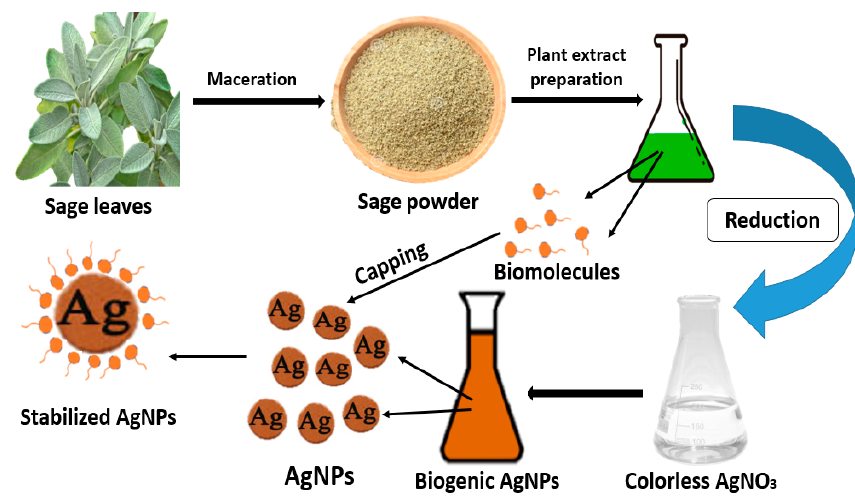
Figure 2. Schematic illustration of the preparation of the biogenic AgNPs utilizing S. officinalis aqueous leaf extract.